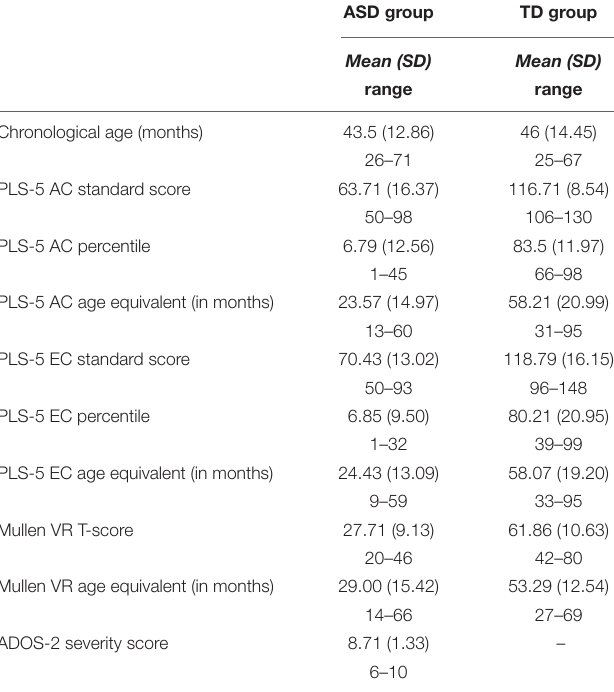
TABLE 1 | Child demographic